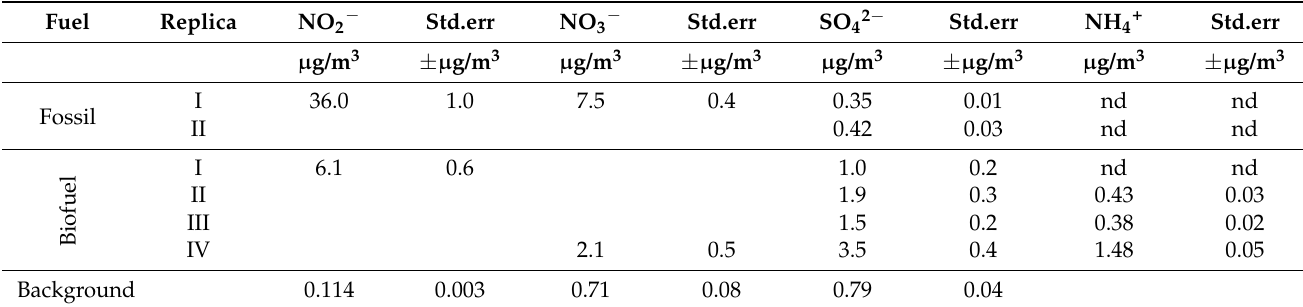
Table 5. Airborne concentration of ionic species measured on filters collected during the different tests. Data are reported as average and standard error (n > 2). Concentrations below the detection limit of the technique are reported in the table as nd (not detected). Blank cells represent missing values.